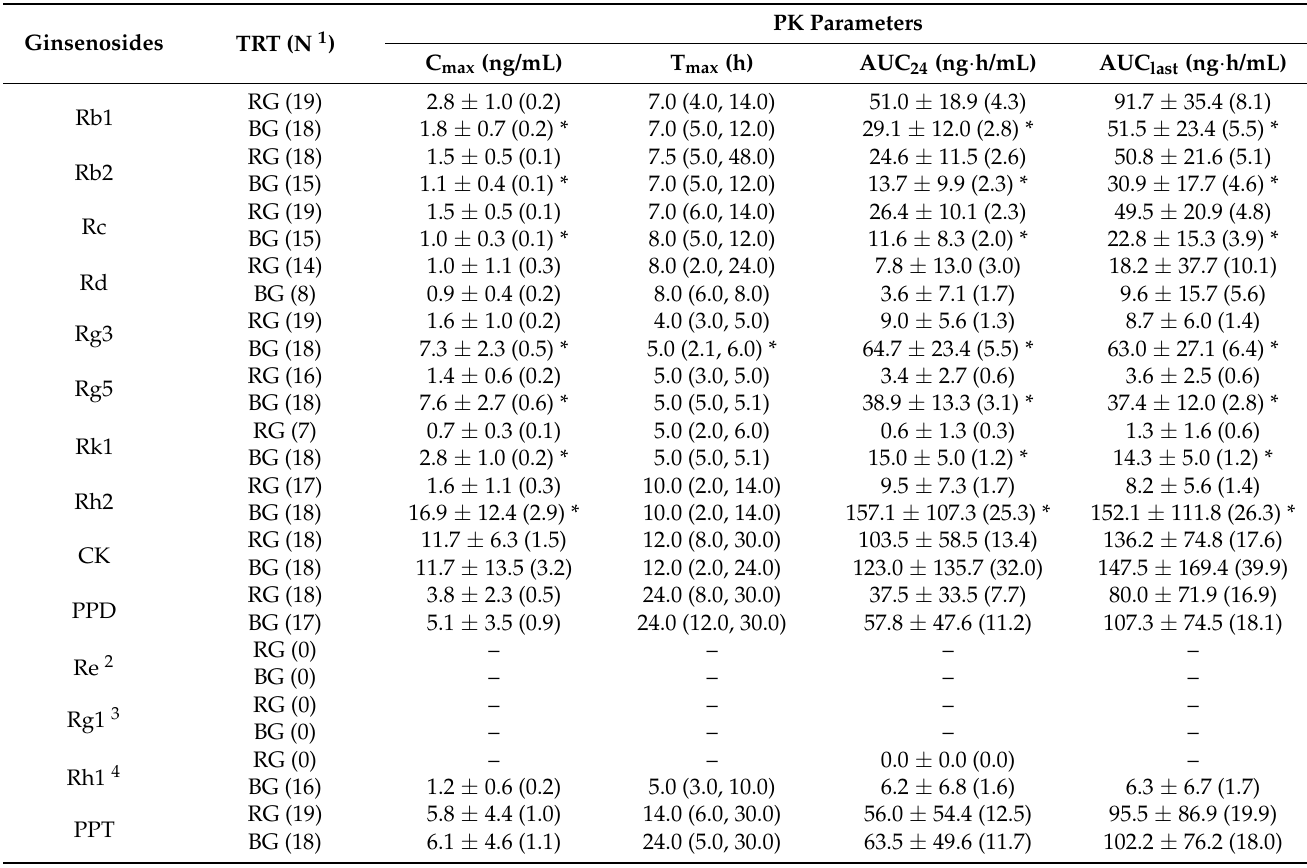
Table 1. Pharmacokinetic (PK) parameters of individual ginsenosides in healthy male volunteers after a cross-over administration of black ginseng (BG) and red ginseng (RG).